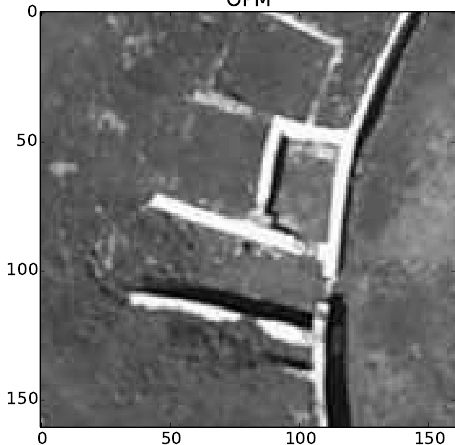
Figure 5: Detail of grey-scale version of fig. 3, with cast shadows, serving as template for image matching.